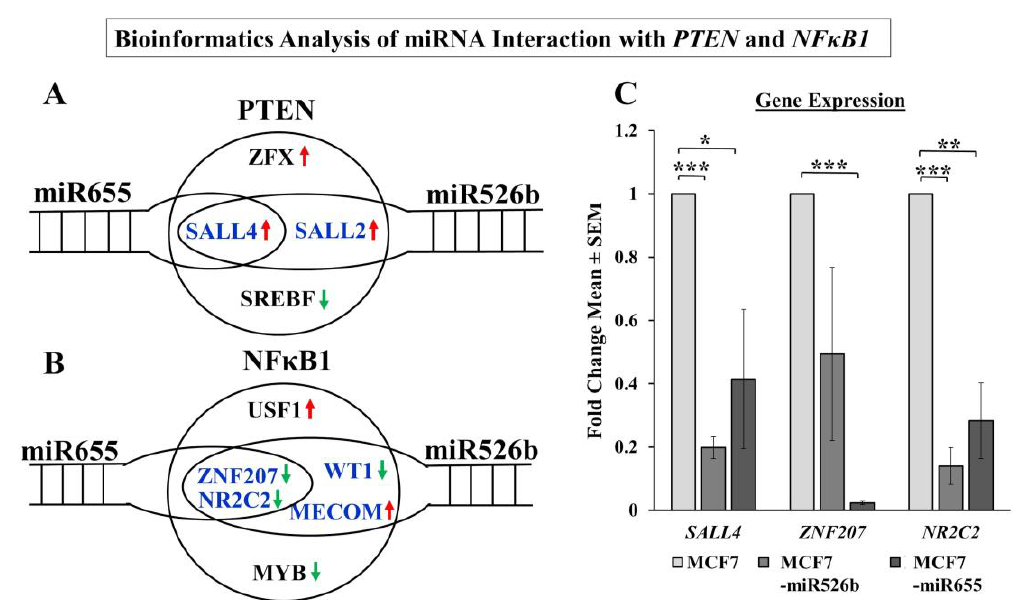
Figure 11. Bioinformatics analysis of the regulation of PTEN and NF κ B1 by miRNA-high cells: ( A ) regulation of PTEN by miR655 and miR526b through transcription factors SALL2 and SALL4 . ( B ) Regulation of NF κ B1 by miR655 and miR526b through transcription factors MECOM , NR2C2 , WT1 , and ZNF207 . Red arrows indicate that the transcription factor upregulates gene expression, green arrows indicate that the transcription factor inhibits gene expression. ( C ) Gene expression of transcription factors targeted by both miRNAs ( SALL4 , ZNF207 , and NR2C2 ) in MCF7, MCF7-miR526b, and MCF7-miR655 cell lines. Data are presented as the mean ± SEM of quadruplicate biological replicates. * p < 0.05, ** p < 0.001 and *** p < 0.0001.